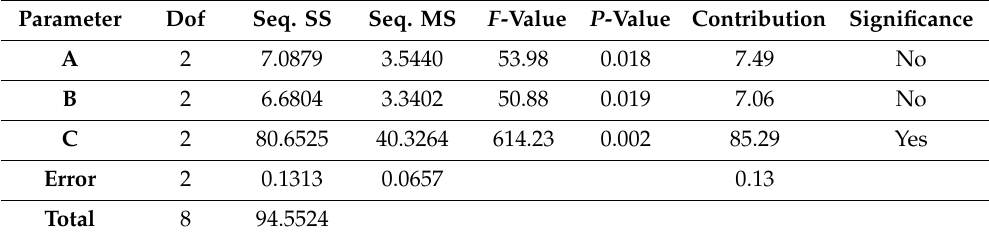
Table 4. Results of ANOVA tests for weight